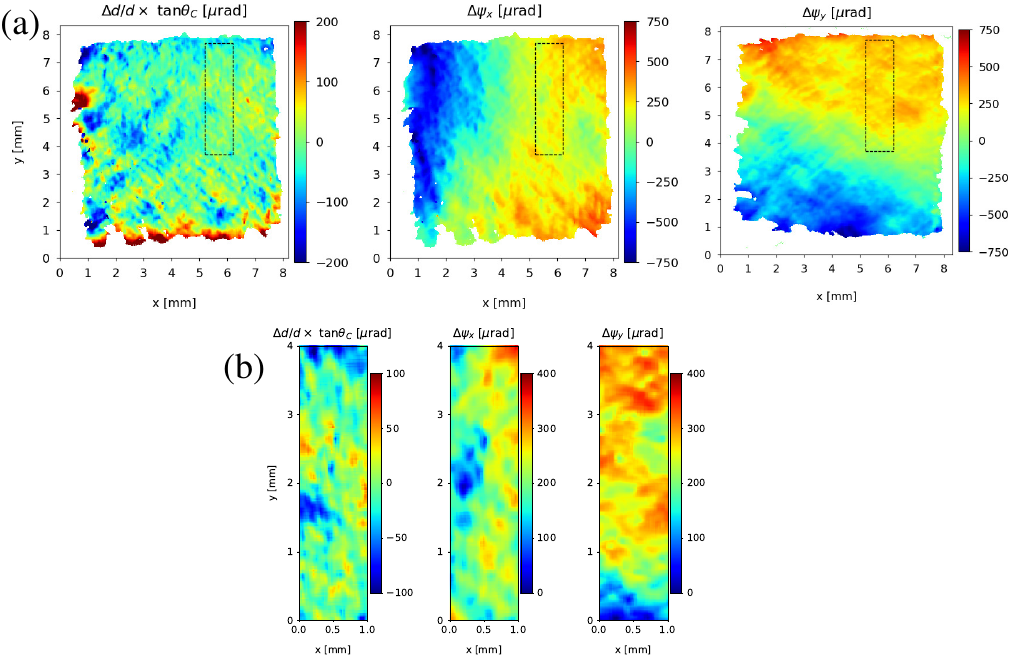
Figure 5. Decoupled dilational and rotational contributions to the effective tilt δθ m for plate CVD-N: ( a )for the entire crystal; ( b ) for the region of interest where the radius of curvature is maximized R 0 (cid:38) 50